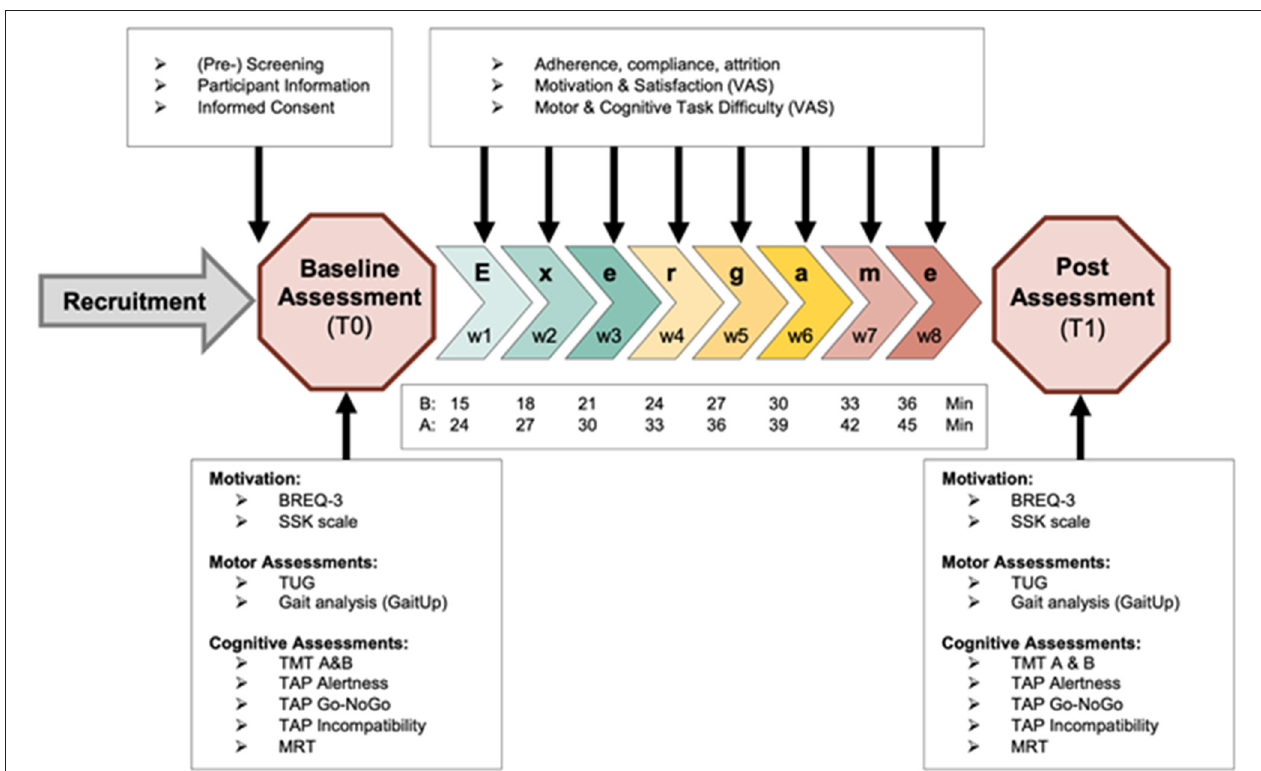
FIGURE 1 | Study flowchart, shows all study procedures and intervention details. B, basic training group; A, Advanced training group; Min, minutes of training in the respective week; VAS, visual analog scale; BREQ-3, Behavioral Regulation in Exercise Questionnaire; SSK, Sport- and Movement-specific Self-Concordance scale; TUG, Timed-up-and-go test; TMT, Trail making test; TAP, Test of attentional performance; MRT, mental rotation test.